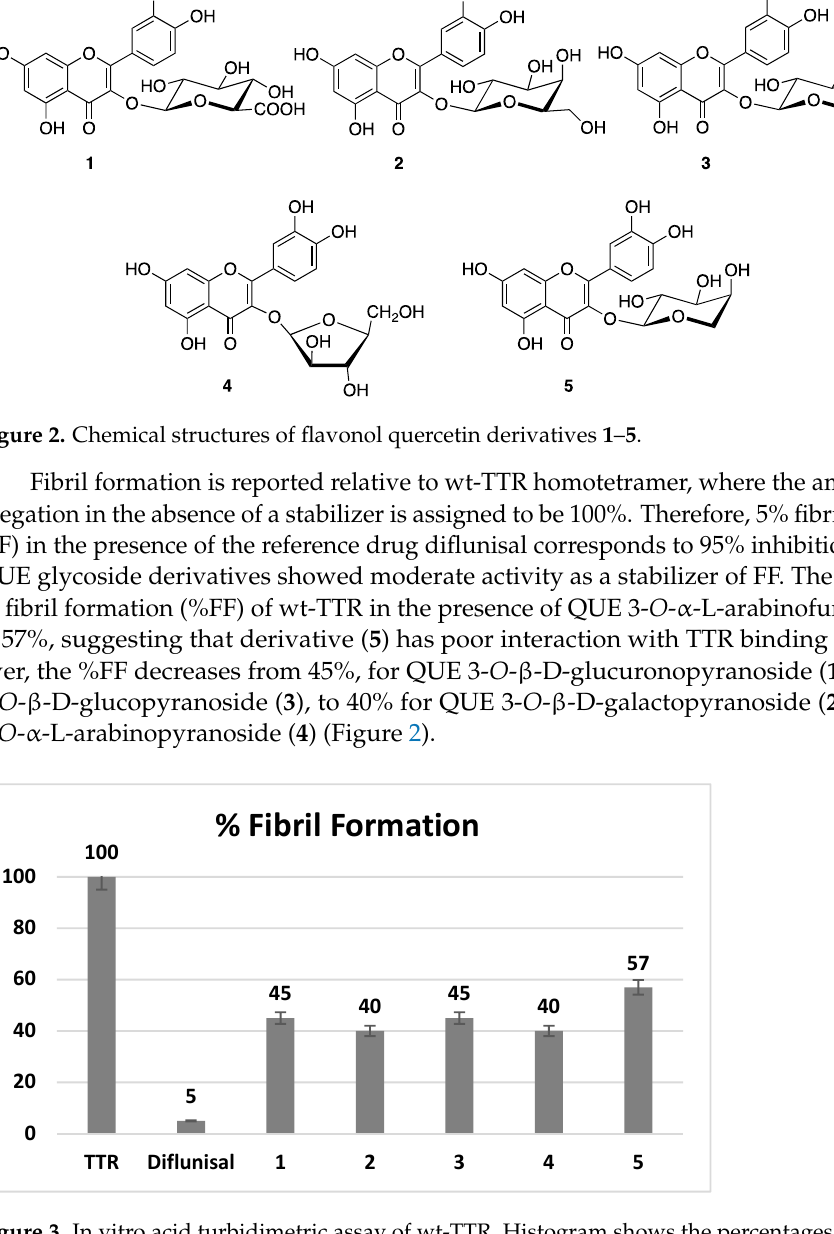
Figure 3. In vitro acid turbidimetric assay of wt-TTR. Histogram shows the percentages of aggregate formation related to glycoside derivatives 1 – 5 . The fibril formation in the absence of a stabilizer was assigned to be 100%. The error in the fibril formation assay is ±